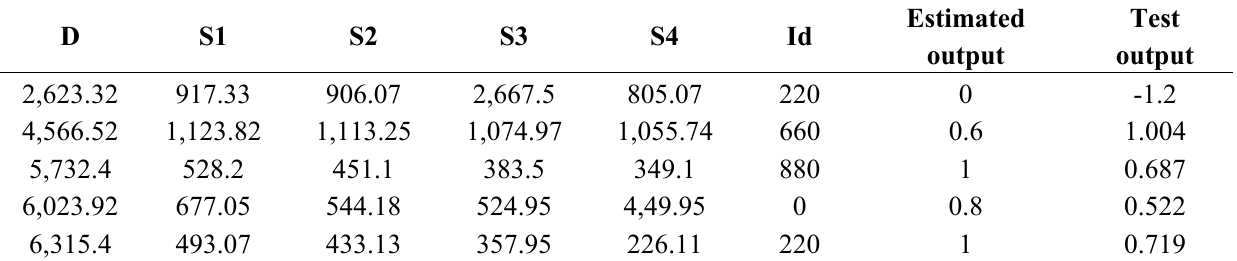
Table 5. Outputs of the Neuro-Fuzzy system for real data and the simulated data in the case, where a wall is being detected. S1, S2, S3, S4, Id and D values are given in millimeters.